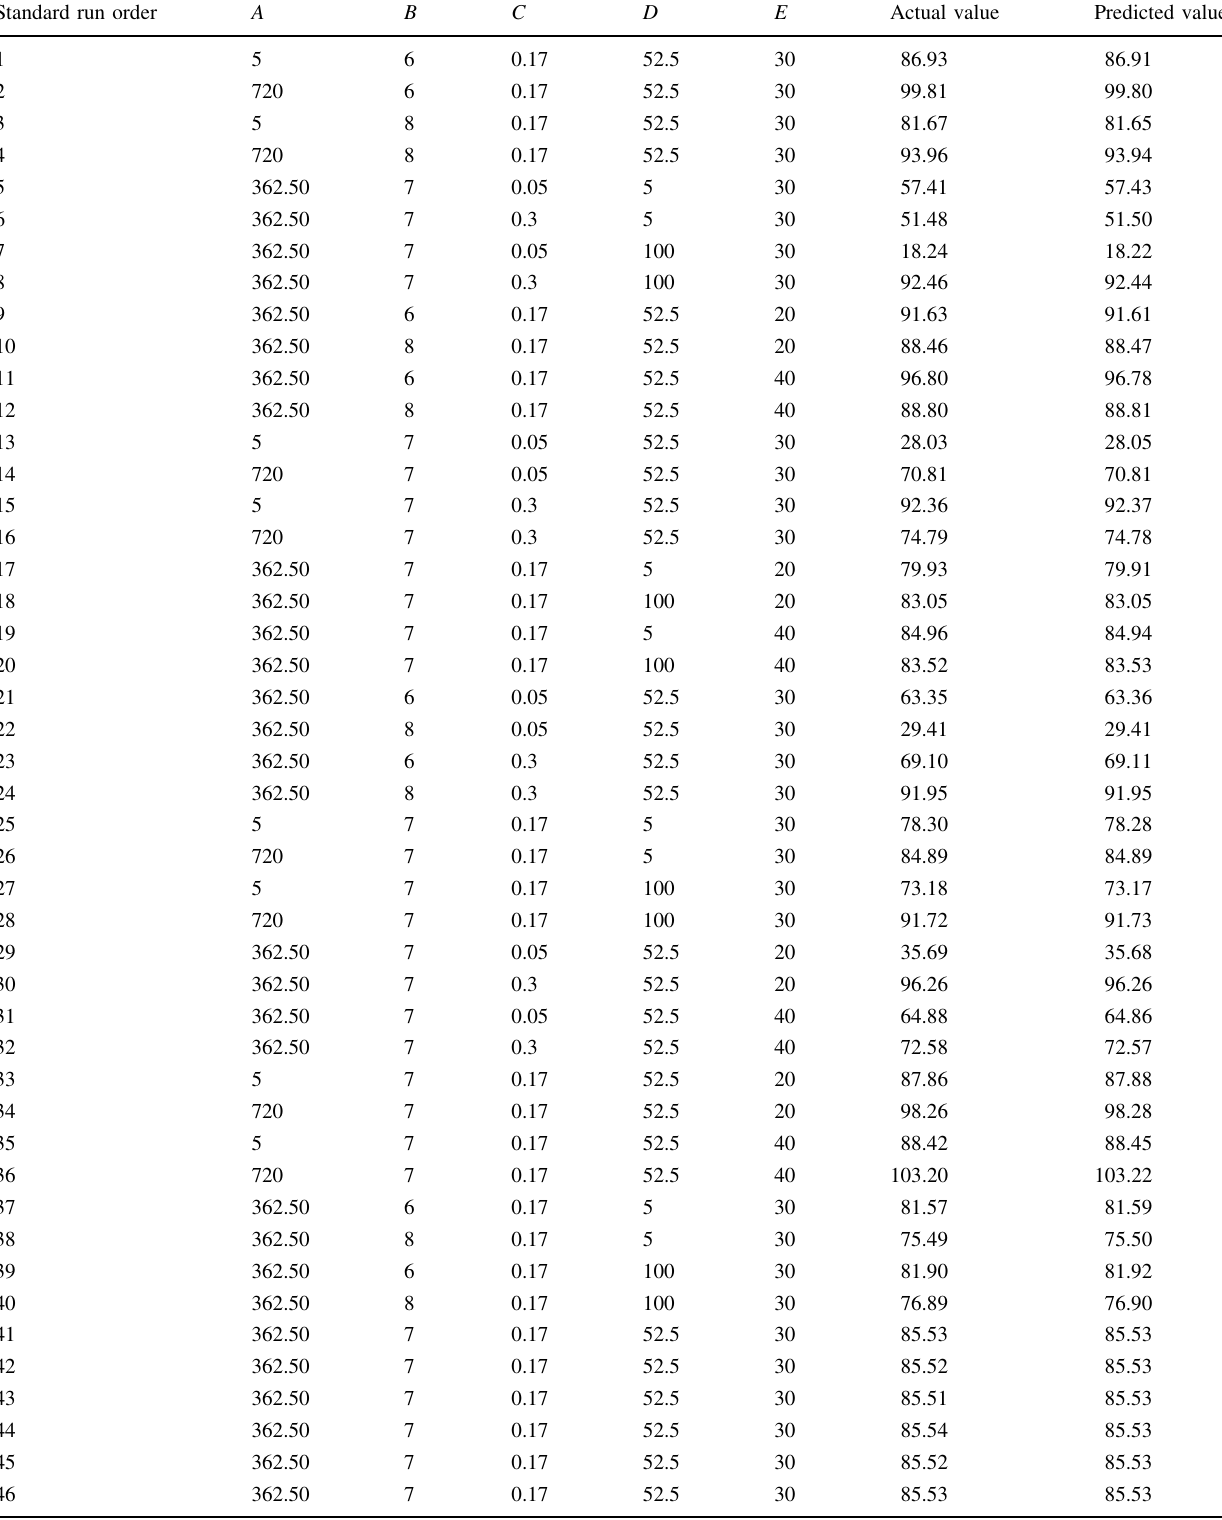
Table 3 Experimental, actual and predicted values of Y for As(III) onto MPKSF Standard run